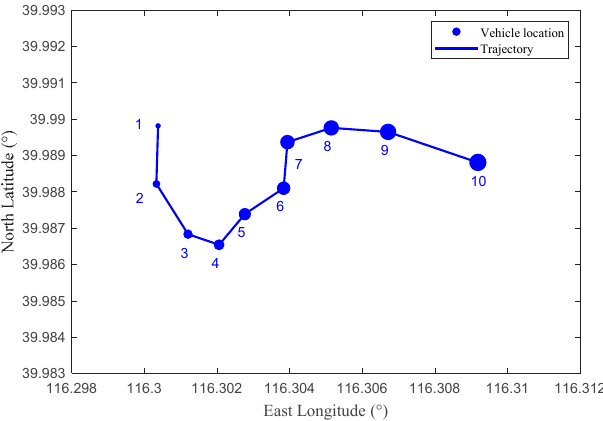
Figure 7. The true trajectory of a vehicle user without location privacy preservation method.